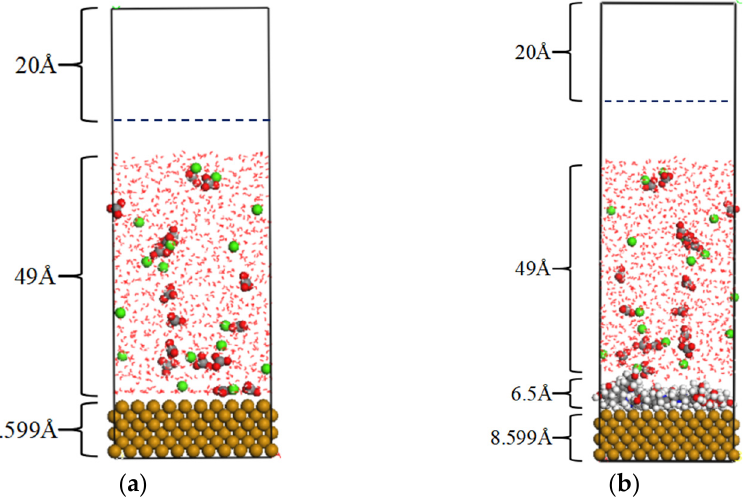
Figure 2. Initial simulation system: ( a ) Fe plate and ( b ) Fe plate with PDA coating.